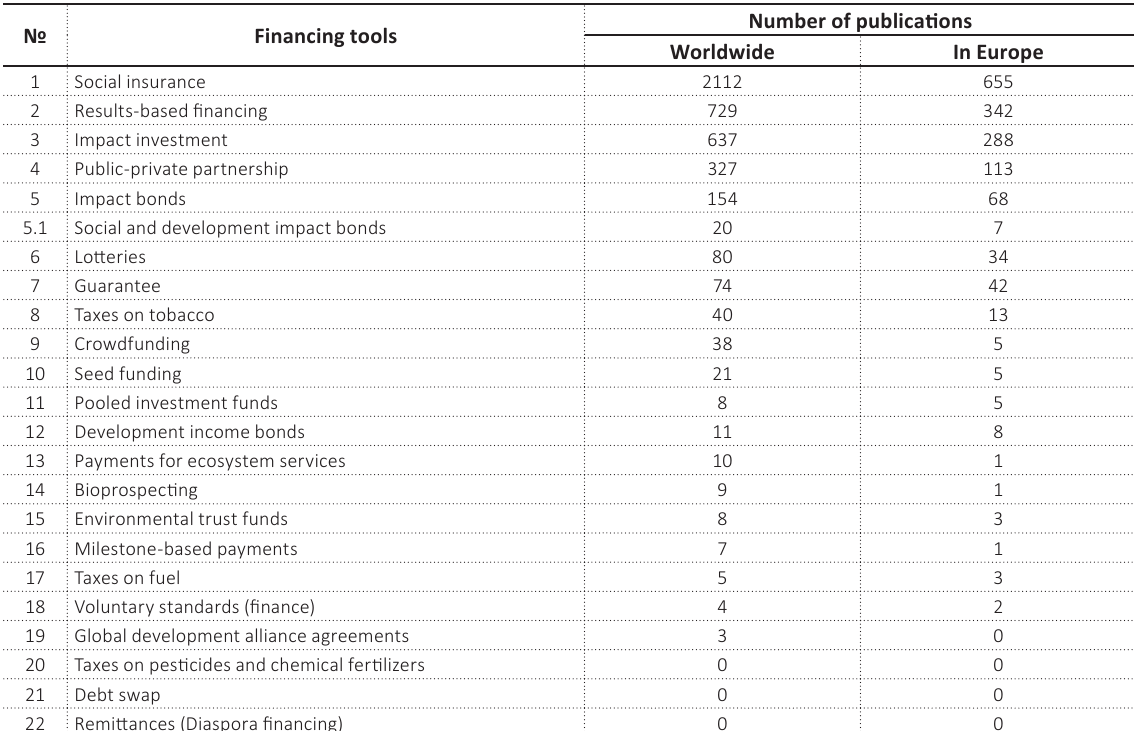
Table 6. Prioritization of financing tools in healthcare according to the number of publications in the Scopus database as of July 10,